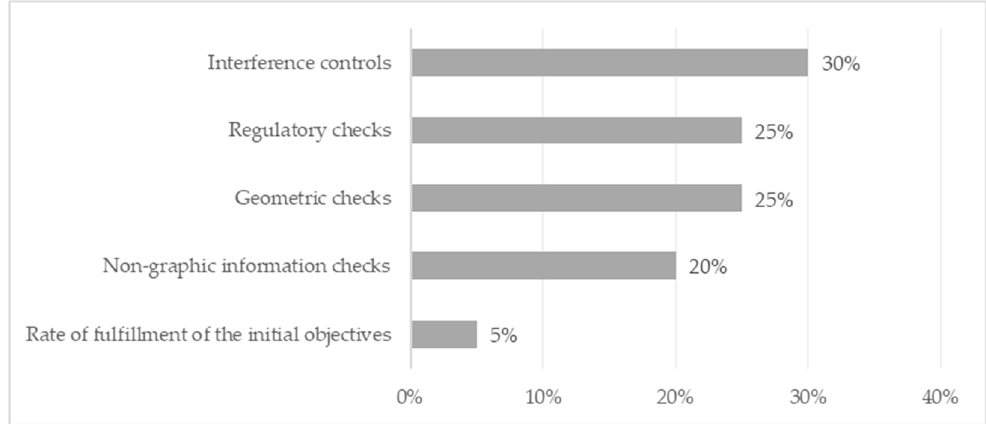
Figure 12. Quality controls identified in the analyzed contracts.